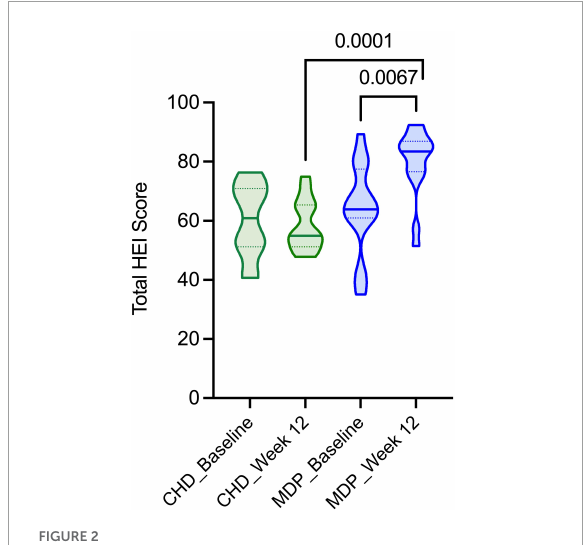
FIGURE2 The HEI-2015 scores for the Mediterranean diet pattern and Canada’s Habitual Diet Pattern. Consumption of the MDP resulted in improved diet quality compared to the CHD at week 12 and improved following the diet intervention (baseline to week